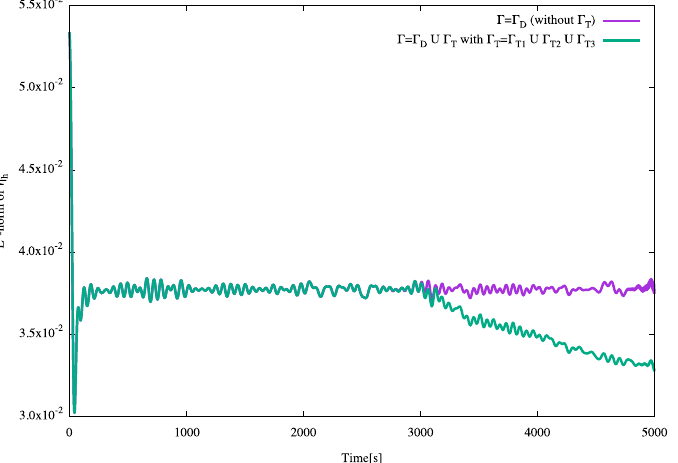
(cid:107) L 2 ( Ω ) with respect to time h